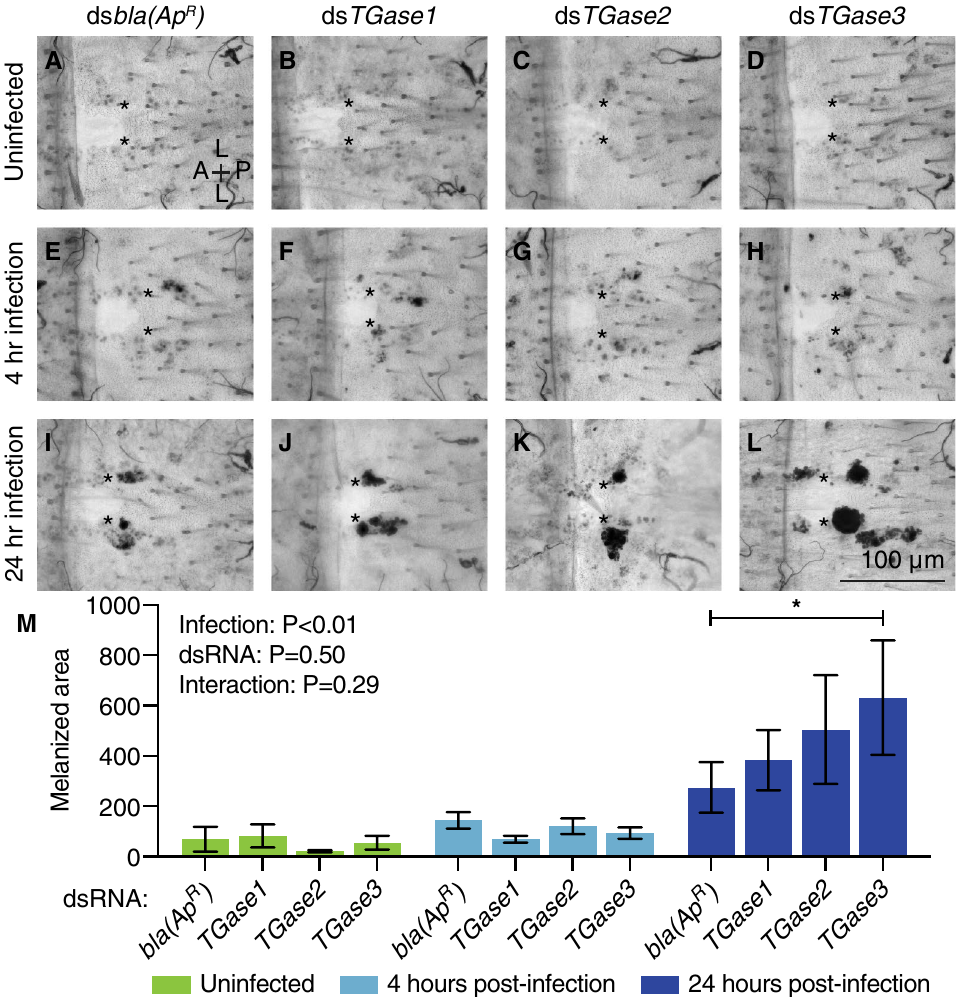
Figure 5. RNAi-based knockdown of TGase3 increases melanin accumulation at the periostial regions. ( A–L ) Brightfield images show a single abdominal segment with melanin deposits (black) surrounding the ostia (asterisks) in uninfected mosquitoes ( A – D ), and mosquitoes that had been infected with GFP- E. coli for 4 ( E – H ) or 24 h ( I – L ). Prior to treatment, mosquitoes had been injected with ds bla(Ap R ) ( A , E , I ), ds TGase1 ( B , F , J ), ds TGase2 ( C , G , K ) or ds TGase3 ( D , H , L ). A, anterior; P, posterior; L, lateral. ( M ) Graph shows the average area of melanin deposits in ds bla(Ap R )- , ds TGase1- , ds TGase2- and ds TGase3- injected mosquitoes that were not infected or had been infected with GFP- E. coli for 4 or 24 h. Data were analyzed by two-way ANOVA followed by Dunnett’s post-hoc test, using ds bla(Ap R ) mosquitoes as the reference. Column heights mark the means, whiskers show the S.E.M., and the asterisk indicates post-hoc P <